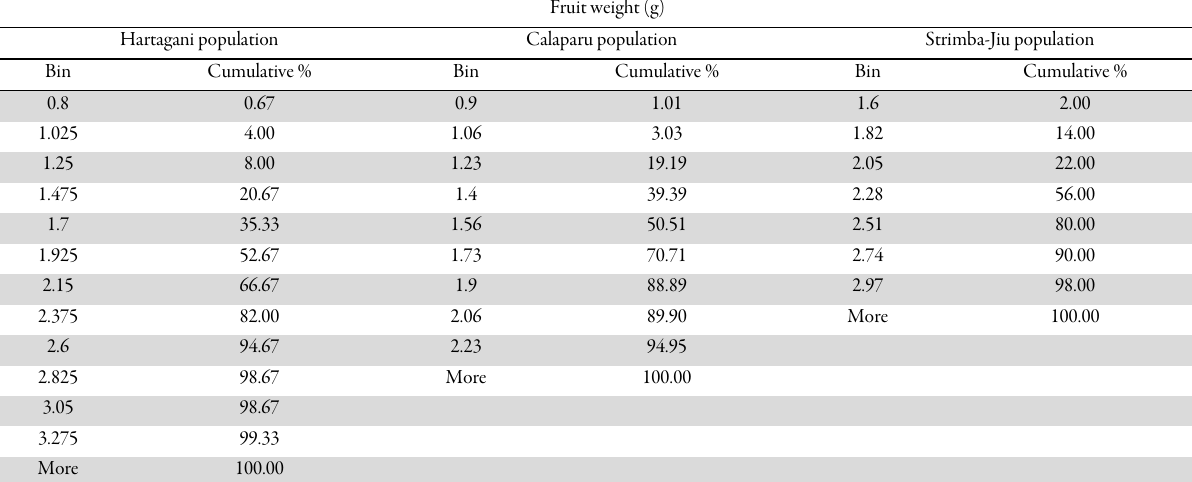
Table 3. Fruit distribution in selected genotypes depending on fruit weight